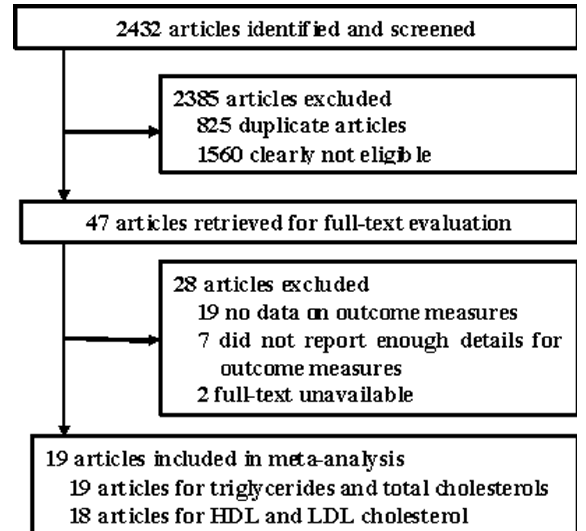
Figure 1. Flow diagram showing the number of citations retrieved by individual searches of articles included in the review.